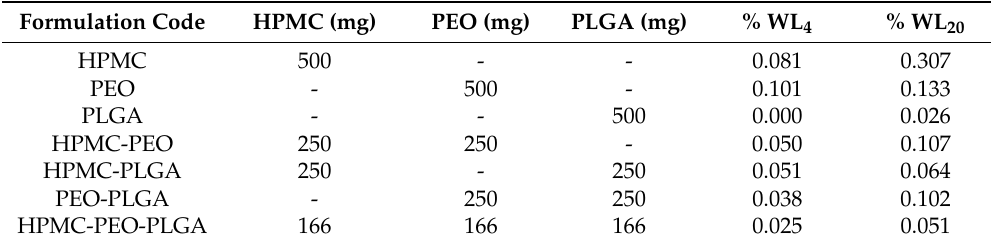
Table 1. Polymeric compositions of the various external matrix formulations. Friability results for polymeric matrices expressed as % weight loss after 4 (% WL 4 ) and 20 (% WL 20 ) minutes in a friabilator at 25 rpm. HPMC: hydroxypropylmethylcellulose; PEO: polyethylene oxide; PLGA: poly(lactic- co -glycolic)